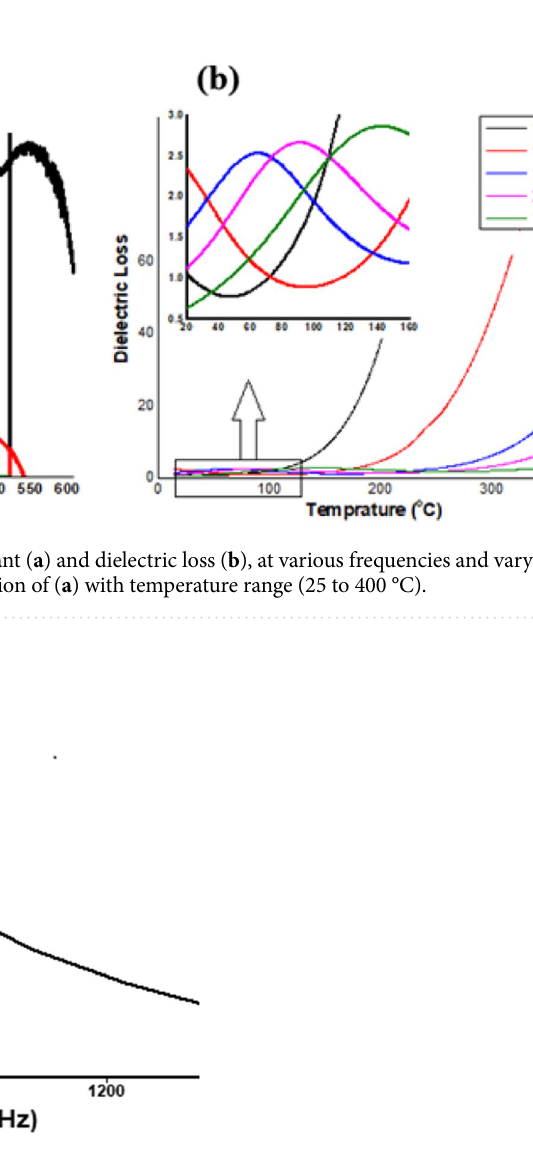
Table 2. The elemental composition of the manganese ferrite grains as shown in Fig. 2.